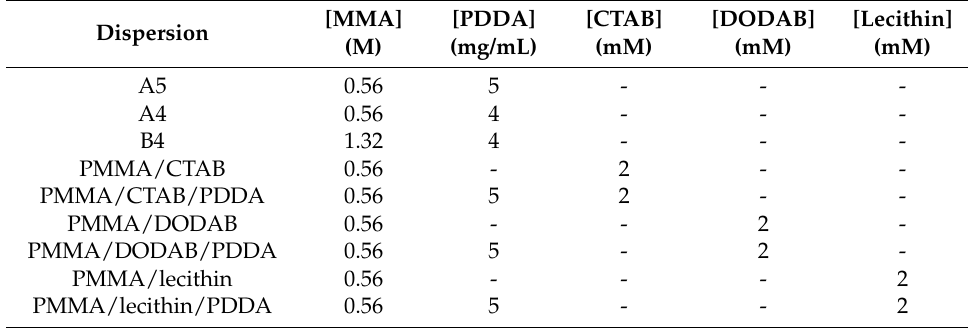
Concentrations of MMA, PDDA, cetyl trimethylammonium bromide (CTAB), dioctadecyldimethyl ammonium bromide (DODAB), and/or lecithin used to synthesize hybrid NPs by emulsion